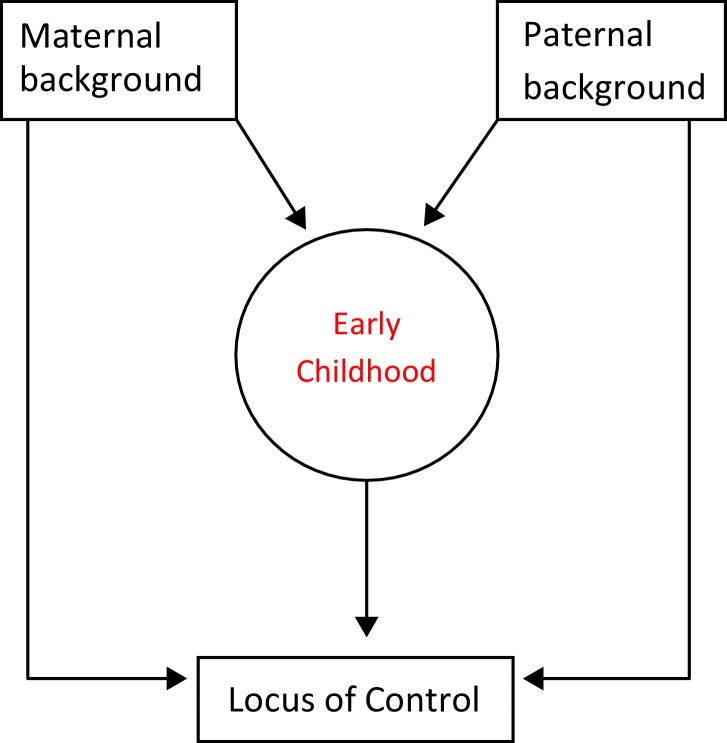
Theoretical depiction of the way in which the parental backgrounds and early childhood might influence the woman’s locus of control.